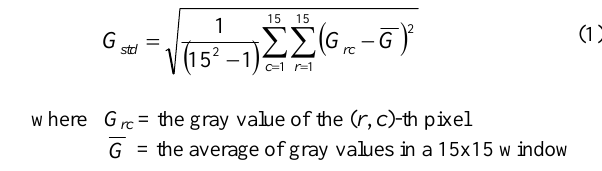
Figure 2. Connection of matched points